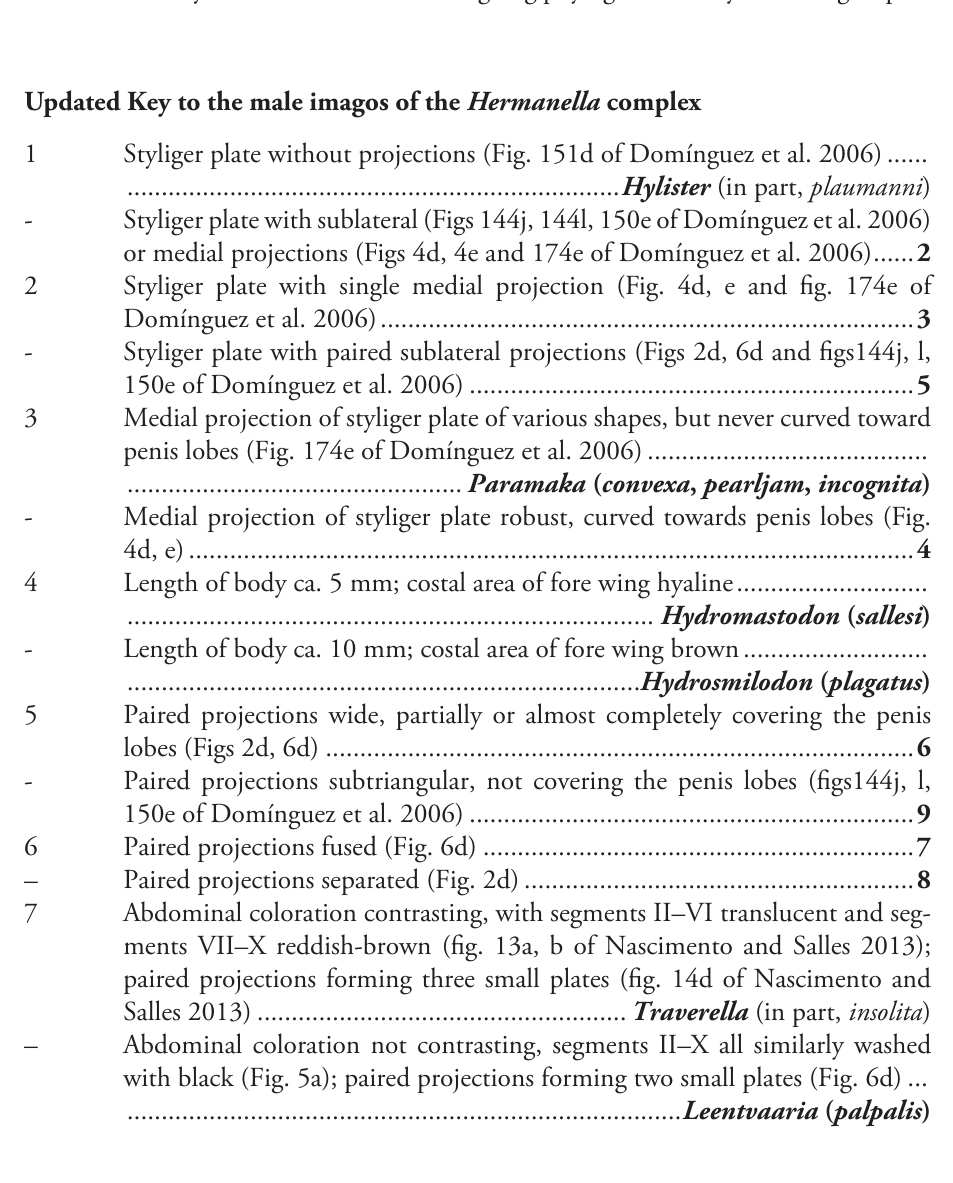
7 Abdominal coloration contrasting, with segments II–VI translucent and seg- ments VII–X reddish-brown (fig. 13a, b of Nascimento and Salles 2013); paired projections forming three small plates (fig. 14d of Nascimento and – Abdominal coloration not contrasting, segments II–X all similarly washed with black (Fig. 5a); paired projections forming two small plates (Fig. 6d)